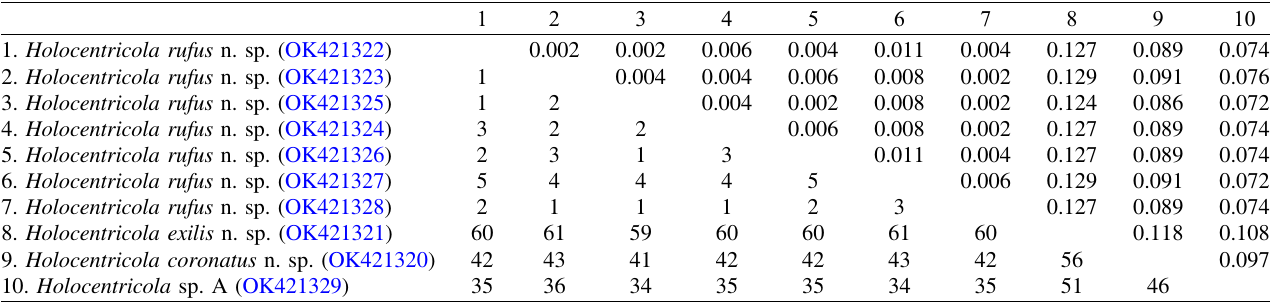
Table 2. Total pairwise cox 1 differences between species of Holocentricola , with number of differences below the diagonal and p -distances